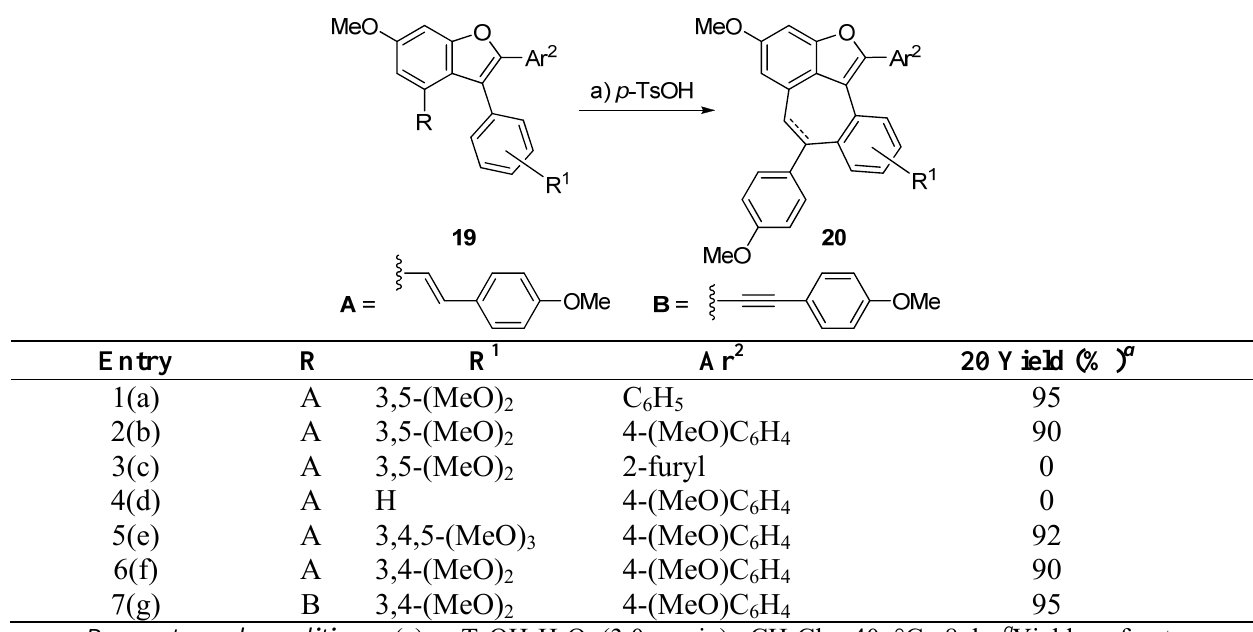
Table 3. Friedel  Crafts type cyclization of benzofurans